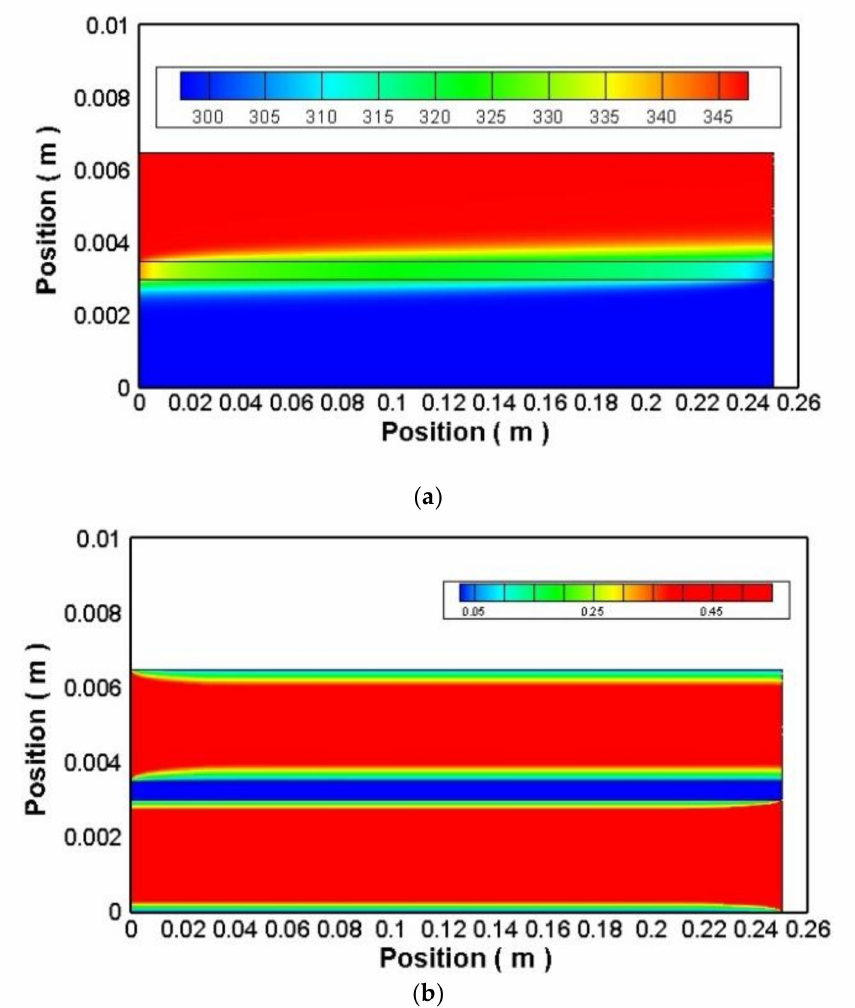
Figure 8. ( a ) Temperature and ( b ) velocity profile at the feed and permeate channels for the horizontal membrane obtained at Reynolds number of